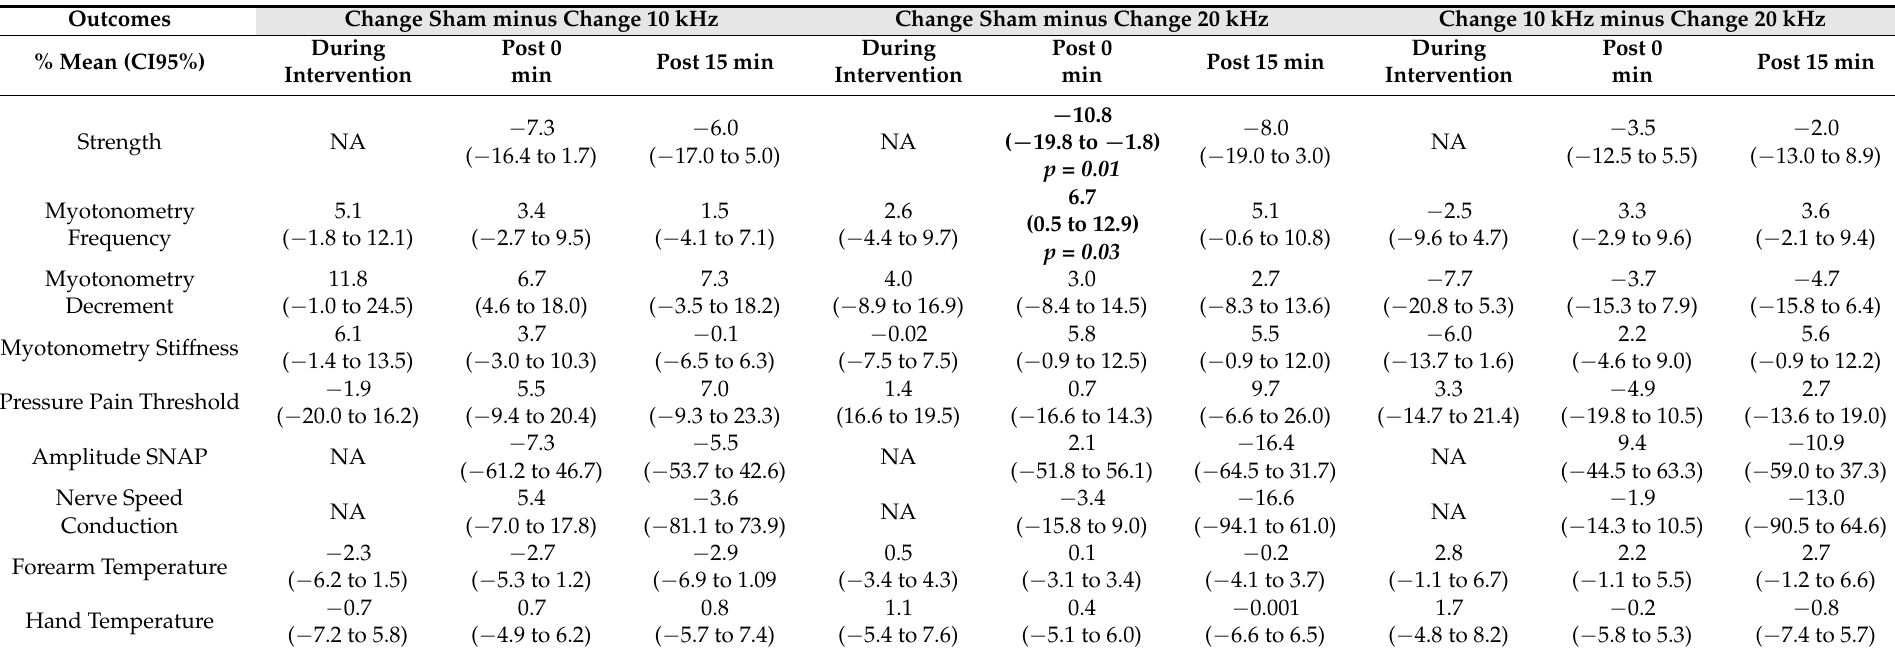
Table 3. Intergroup comparison in the change from baseline. Bold values denote statistical significance. Abbreviations: NA: not applicable; SNAP: sensory nerve action